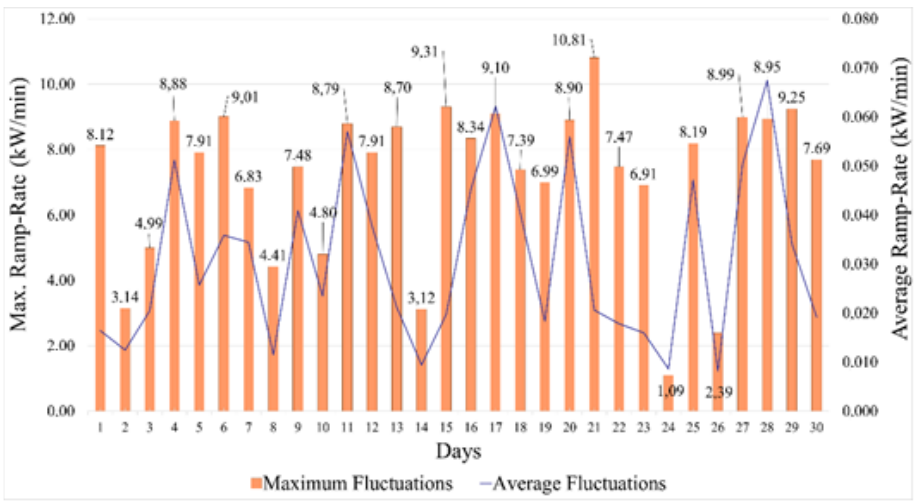
Figure 4. Maximum and average daily fluctuations, September 2020.